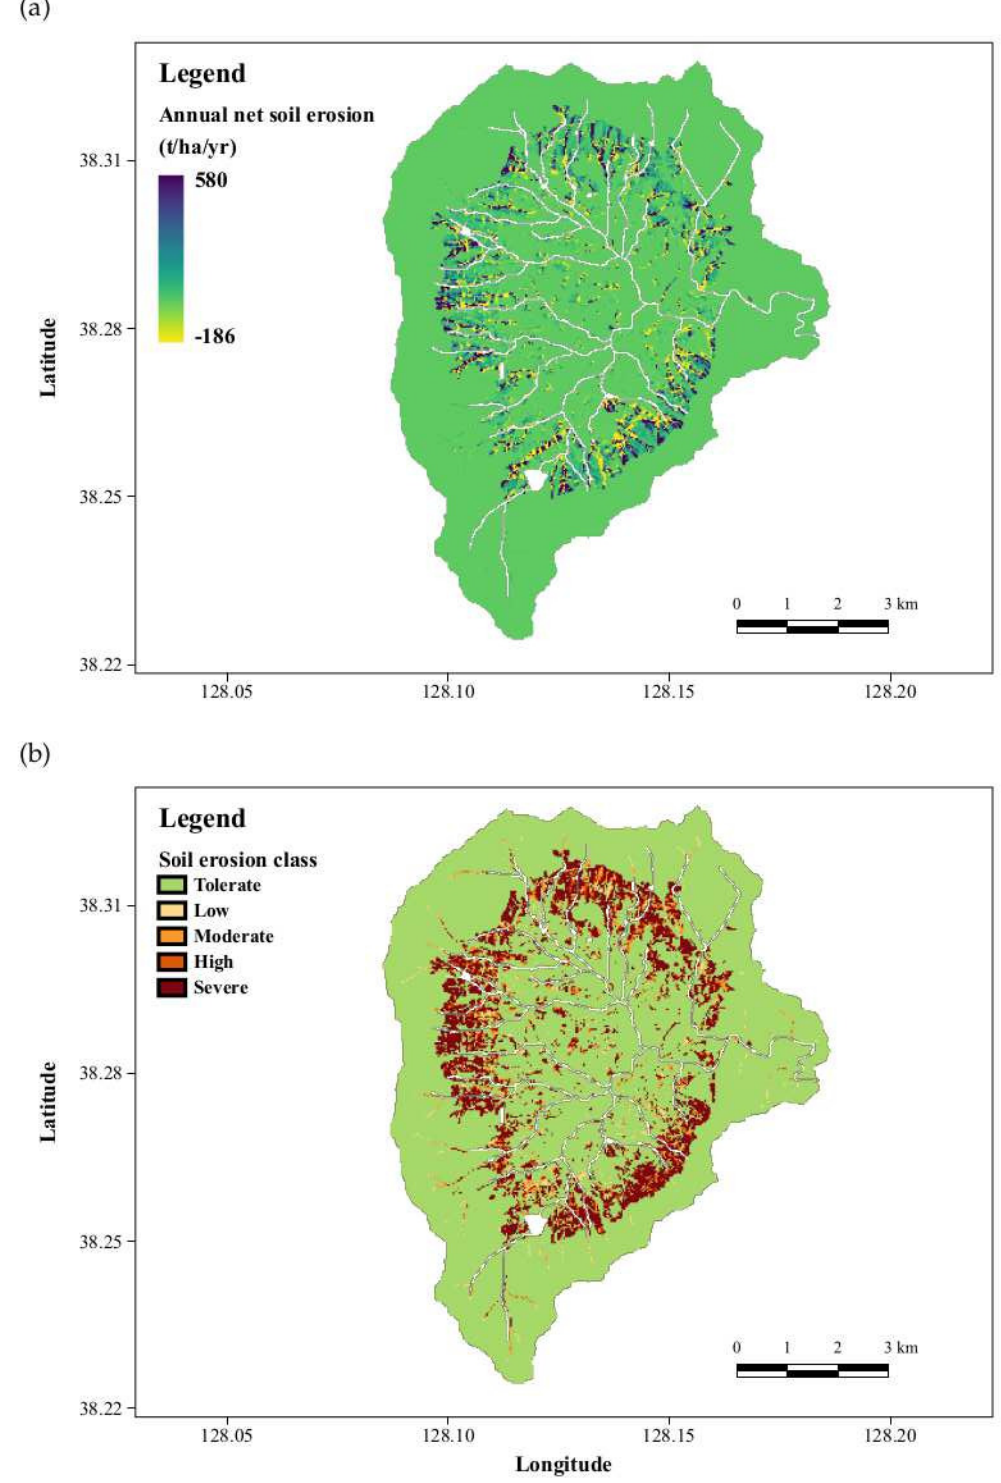
Figure 7. ( a ) Annual net soil erosion (t/ha/year) of the entire Haean catchment and ( b ) soil erosion class according to the soil erosion risk categories from OECD